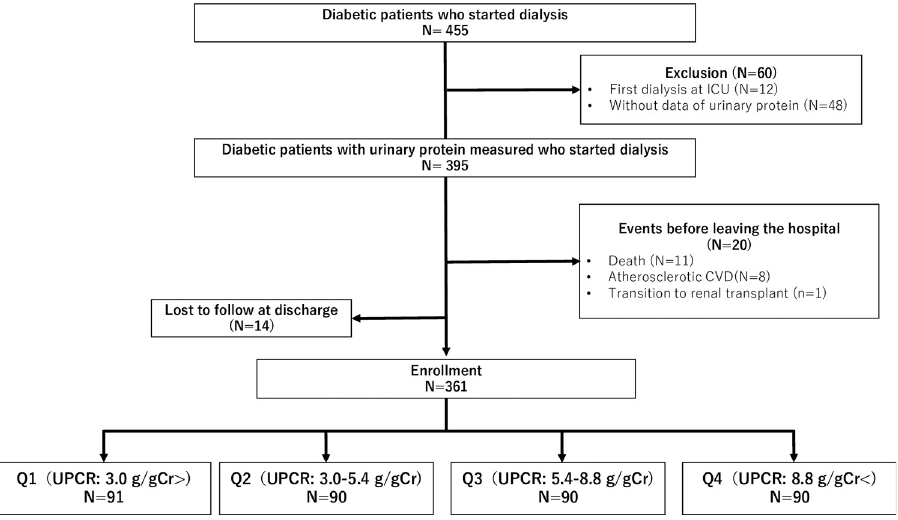
Fig 1. Flow diagram. Abbreviations: CVD, cardiovascular disease; ICU, intensive care unit; Q1-4, quartile 1–4; UPCR, urine protein-to-creatinine ratio.